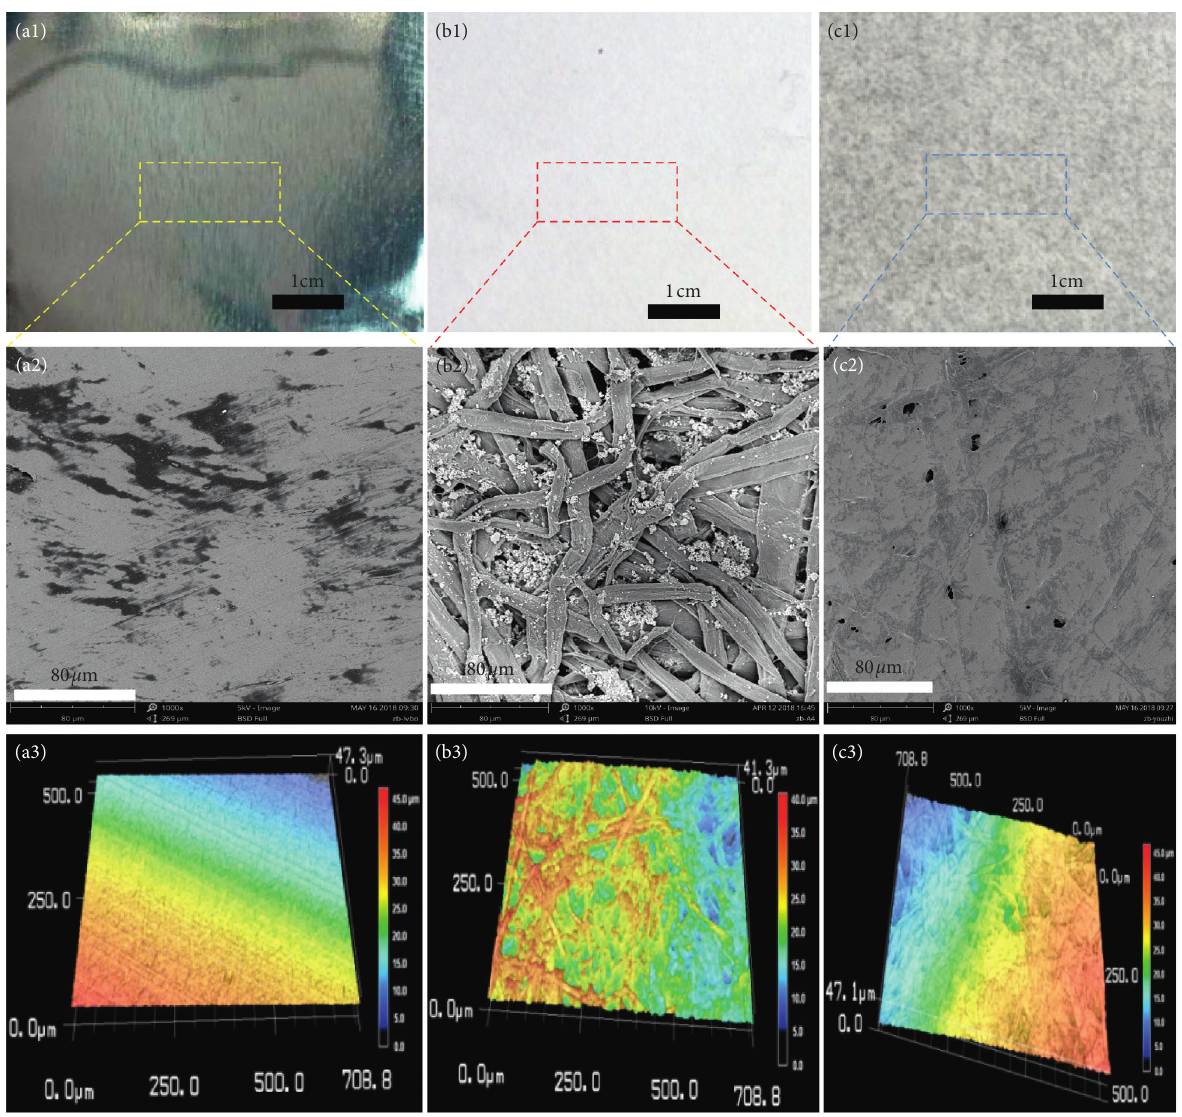
Figure 1: Optical photograph, SEM, and 3D confocal microscopy images of aluminium foil (a1, a2, a3), wood pulp paper (b1, b2, b3), and silicon paper (c1, c2,